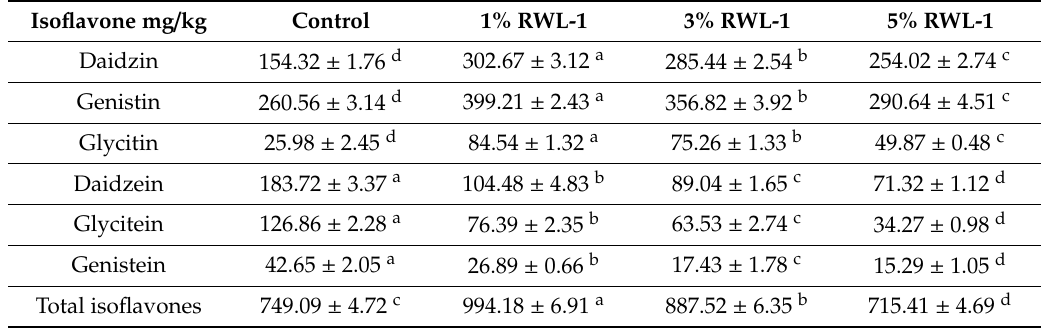
Isoflavones quantification in non-fermented and fermented soybean with various concentrations (1%, 3%, and 5%) of B. amyloliquefaciens RWL-1. Isoflavone mg / kg